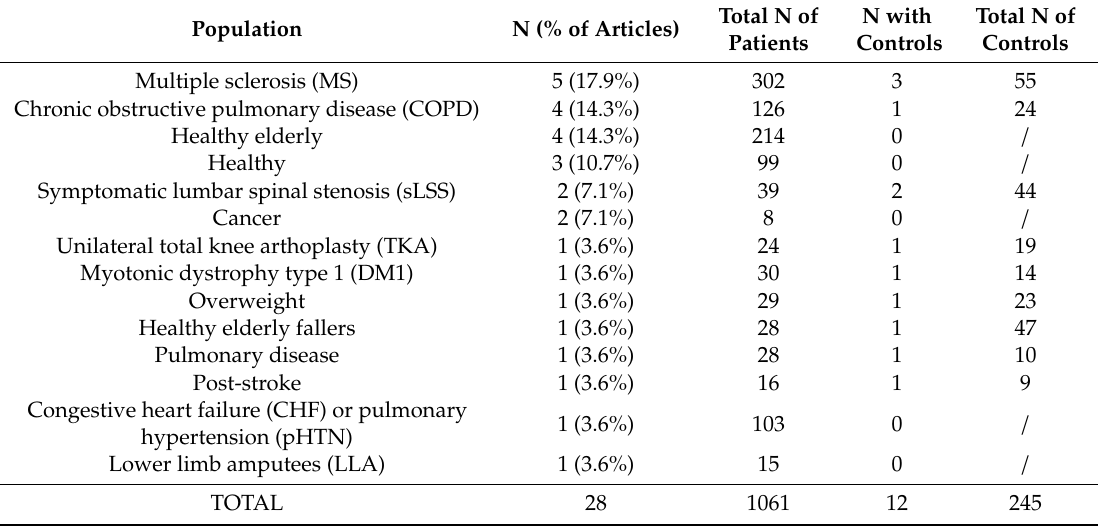
Table 3. Summary of the population types reported in the included